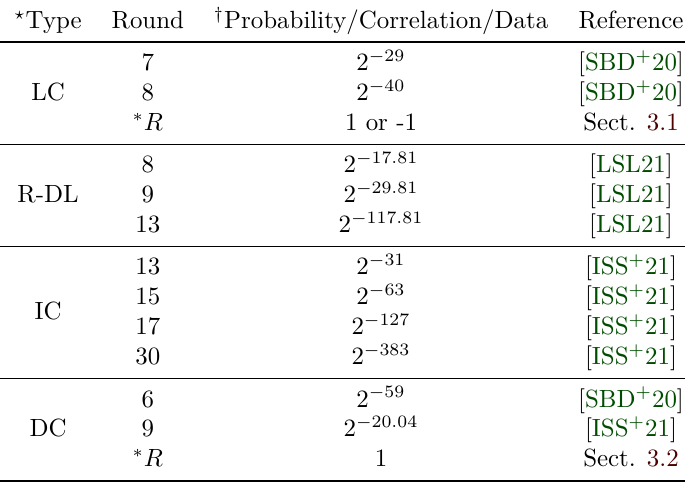
Table 1: The comparison of the distinguishers for FRIET-PC ⋆ Type Round † Probability/Correlation/Data Reference 7 2 − 29 [SBD + 20] LC 8 2 − 40 [SBD + 20] ∗ R 1 or -1 Sect. 3.1 8 2 − 17 . 81 [LSL21] R-DL 9 2 − 29 . 81 [LSL21] 13 2 − 117 . 81 [LSL21] 13 2 − 31 [ISS + 21] 15 2 − 63 [ISS + 21] IC 17 2 − 127 [ISS + 21] 30 2 − 383 [ISS + 21] 6 2 − 59 [SBD + 20] DC 9 2 − 20 . 04 [ISS + 21] ∗ R 1 Sect.